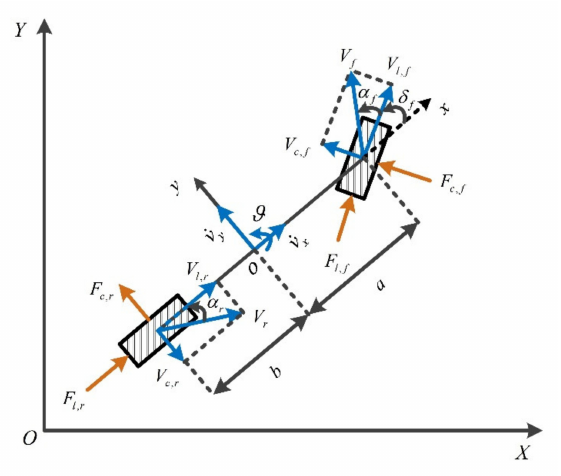
Figure 2. Vehicle dynamics